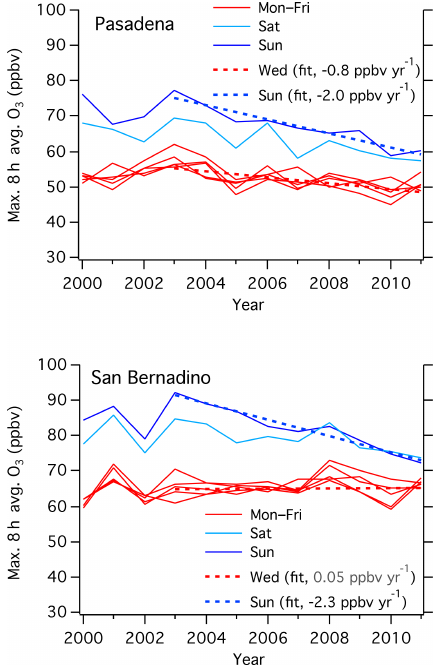
Figure 10. Decadal O 3 trends in Pasadena and San Bernardino dur- ing weekdays (red) and weekends (blue) are shown. The linear least square fits of O 3 for Wednesday and Sunday are plotted in dashed